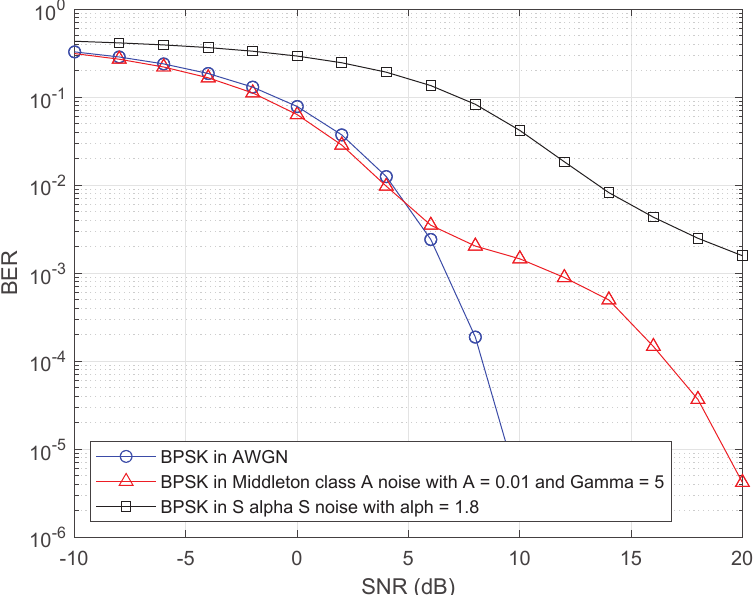
Figure 1. BER of BPSK in various noise environment such as AWGN, Middleton class A noise and S α S noise. Middleton class A noise parameters are set to ( A , Γ ) = ( 0.01,5 ) and S α S noise parameter is set to α =